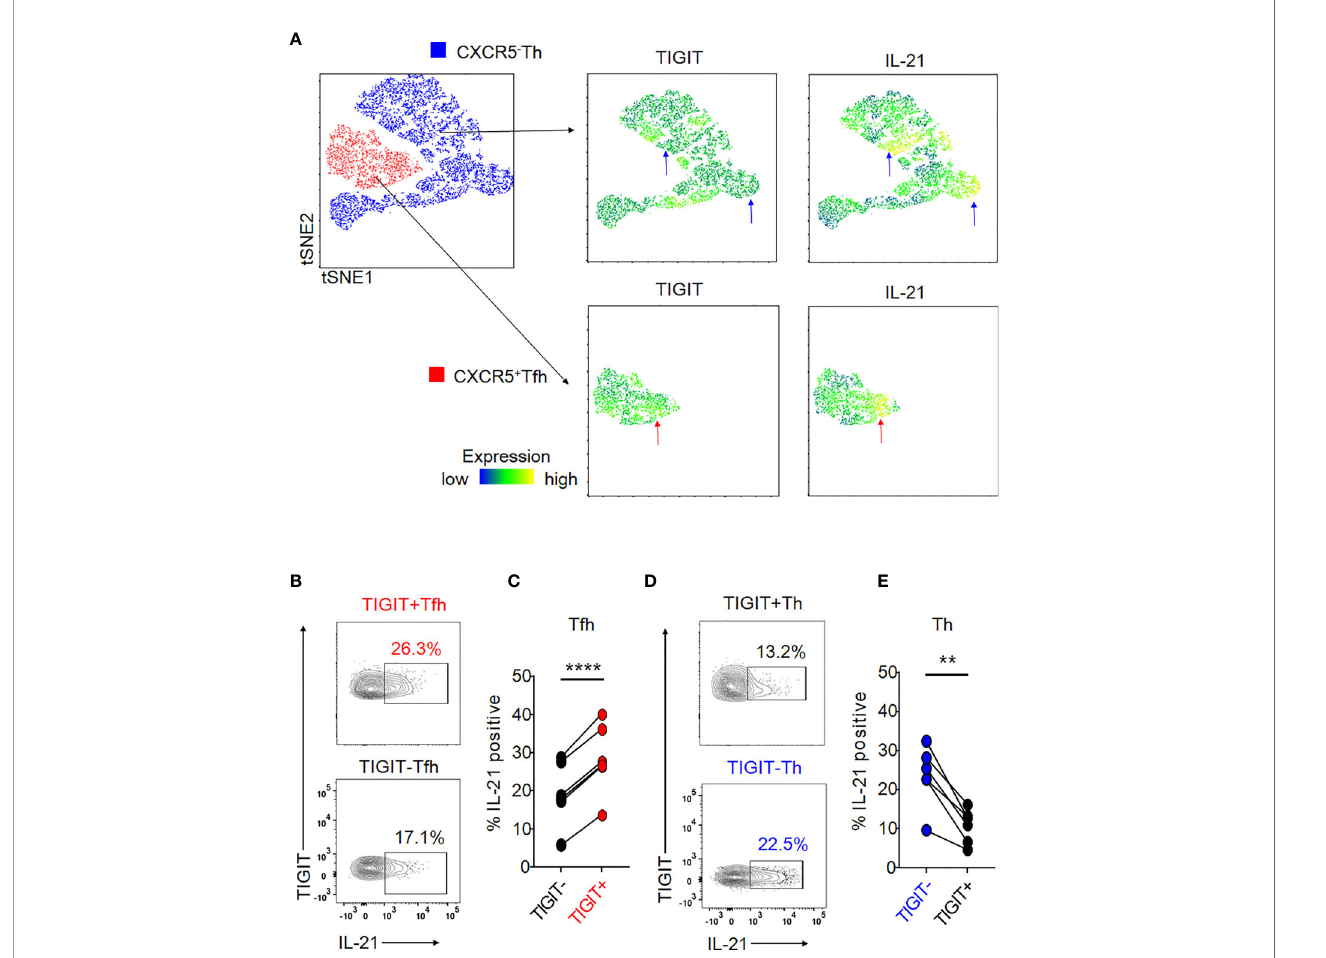
FIGURE 2 | Expression of TIGIT is differentially associated with high IL-21-producing populations in Tfh and Th cells. (A) Single cells in Tfh and Th fractions were plotted by tSNE. Heat maps show expression levels of labeled markers (TIGIT and IL-21). Blue arrows indicate that TIGIT - Th cells express high levels of IL-21. Red arrows show that TIGIT + Tfh cells express high levels of IL-21. (B – E) CD4 + T cells were stimulated for 4 hours with phorbol myristoyl acetate and ionomycin. The proportion of intracellular IL-21 production in TIGIT + or TIGIT - Tfh and TIGIT + Th or TIGIT - Th cells was measured by fl ow cytometry. (B, D) , representative image. (C, E) , multiple comparison of the proportion of IL-21-producing cells (n=6). (C, E) paired t-test. ****p<0.0001,